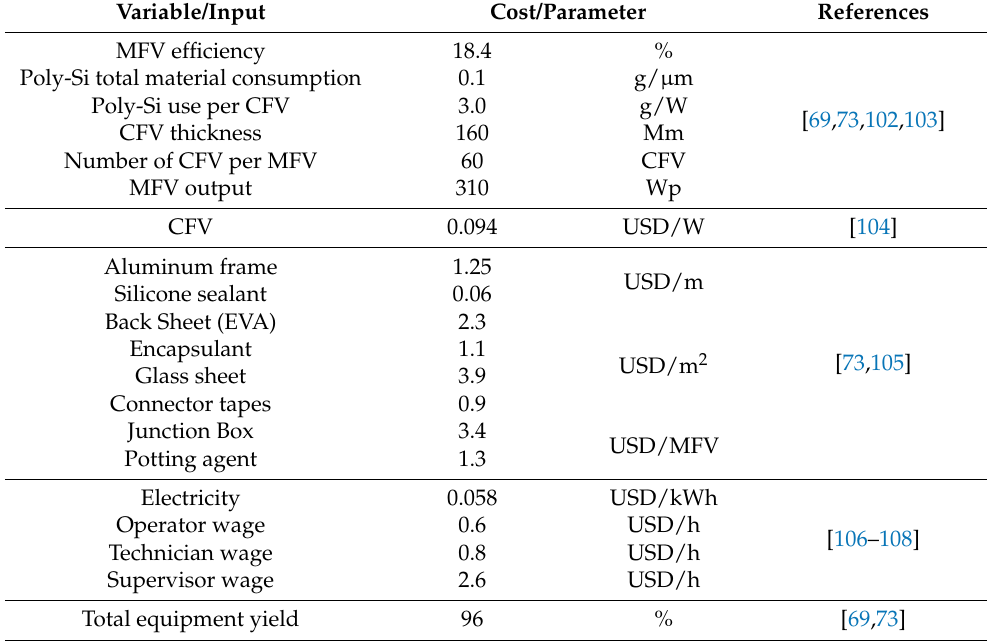
Table 4. Technical and economic variables to determine the proportion of national content and the cost of assembling a photovoltaic module in Mexico for the reference